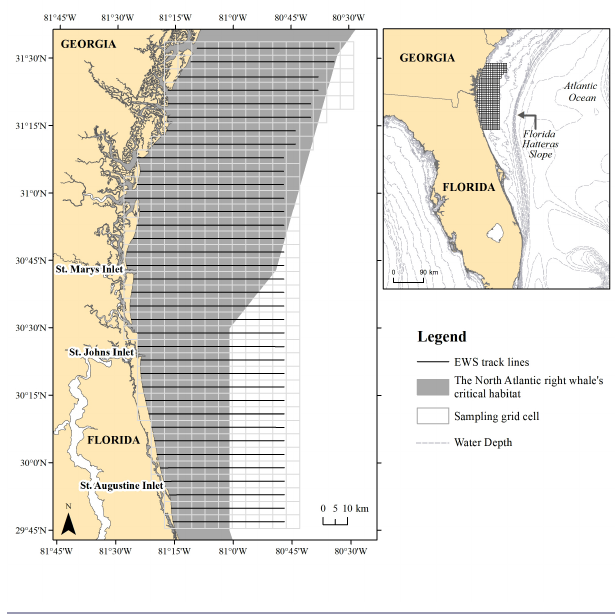
Fig. 1. Study area including Early Warning System (EWS) aerial survey track lines and the sampling grid cells used for the analyses. The image includes the designated critical habitat of the North Atlantic right whale in the southeast United States, and the sampling grid cells are 5.56 x 5.56 km cells ( n =441). Bathymetric depth contours (in 100 m